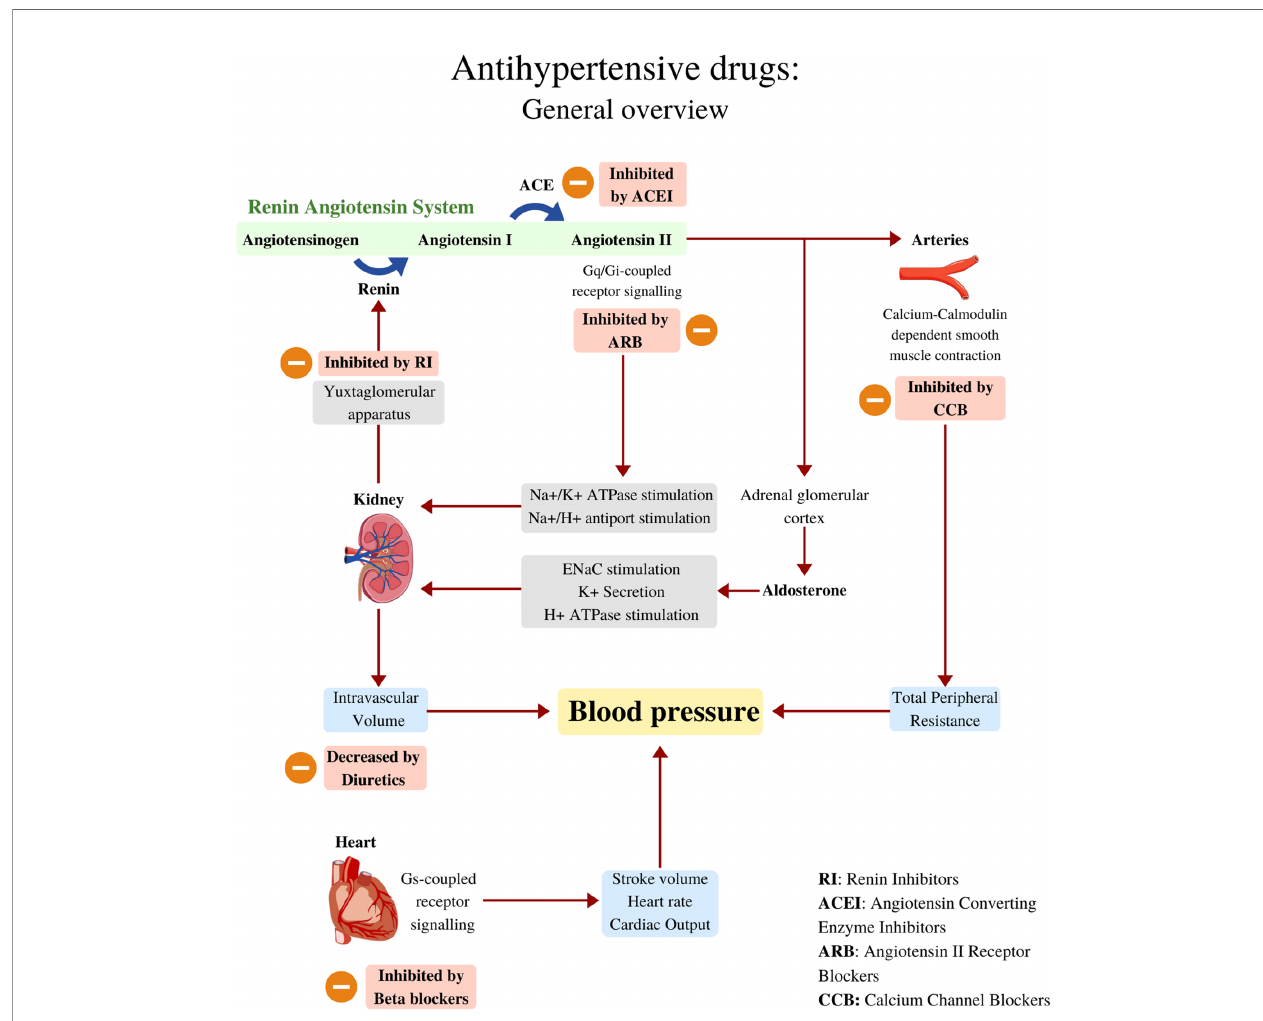
FIGURE 1 | Antihypertensive drugs: General overview. Blood pressure can be determined by changes in cardiac output, total peripheral resistance and intravascular volume. The Renin Angiotensin System is one of the key regulators of blood pressure, it works by increasing Angiotensin II, a powerful systemic vasoconstrictor and one of the main intravascular volume regulators. Angiotensin II works by activating Angiotensin II receptors, which are G-Coupled. Angiotensin II works hand-in-hand with aldosterone to promote sodium and water reabsorption, and hence, maintaining intravascular volume as needed. The heart as a pump, is another blood pressure regulator, it modulates important variables such as Stroke Volume and Heart Rate, which are an important in fl uence for Cardiac Output. Several drugs can lower blood pressure by inhibiting different physiological mechanisms shown in this fi gure. RI, Renin Inhibitors; ACE, Angiotensin converting enzyme; ACEI, Angiotensin converting enzyme Inhibitors; CCB, Calcium-Channel